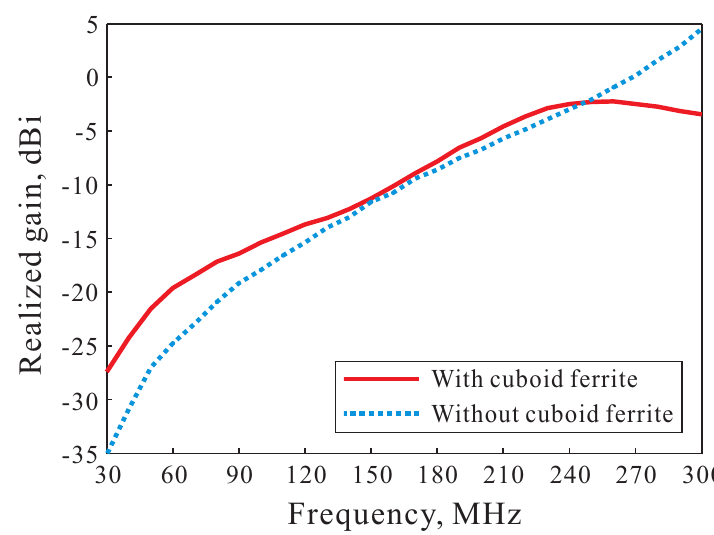
Figure 3. Simulated realized peak gains of the Spidron fractal loop antenna with and without cuboid ferrite.